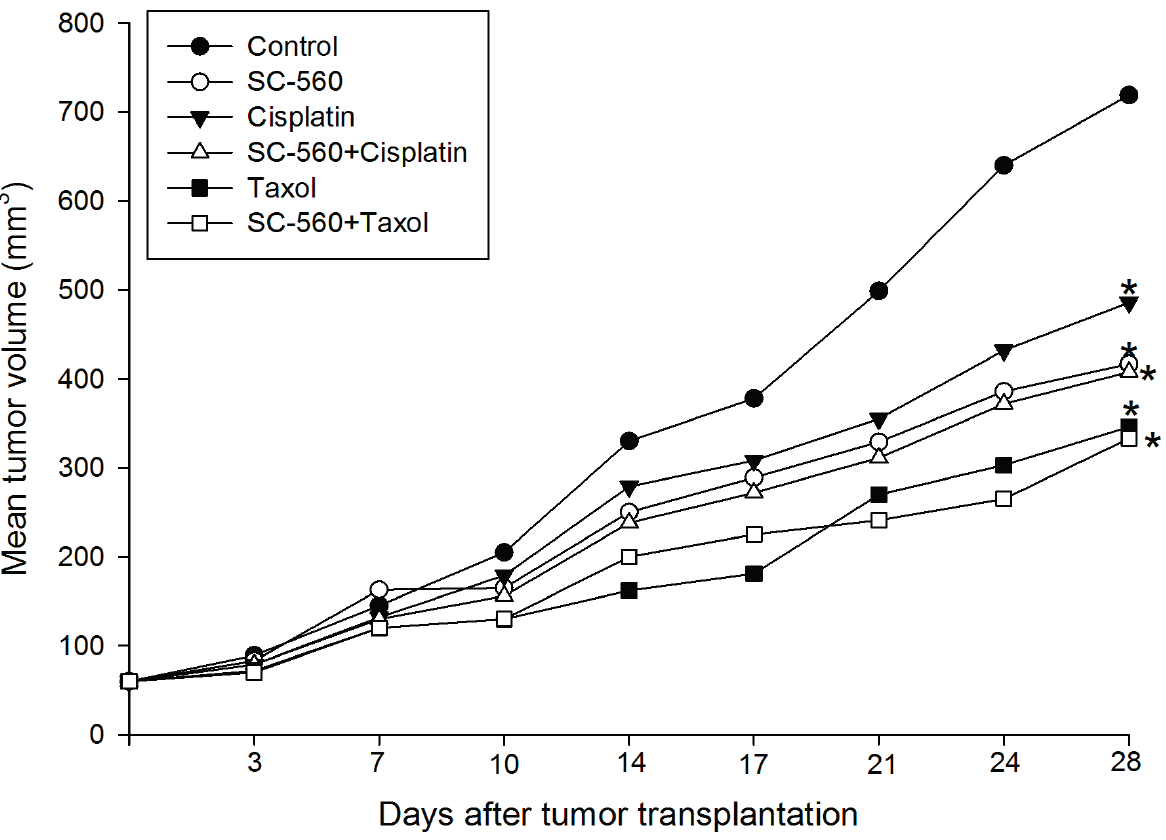
Figure 1. Effects of SC-560 combined with cisplatin or taxol on tumor growth in vivo . After 7 days had elapsed to allow for tumor establishment, mice were randomly separated into six groups (six mice in each group). Mice were treated with SC-560 (3 mg/kg twice a day), cisplatin (3 mg/kg every other day) and taxol (20 mg/kg once a week) for 21 days. Average tumor volume of mice in all treatment groups was significantly different from control mice on day 28. * p < 0.05, compared with